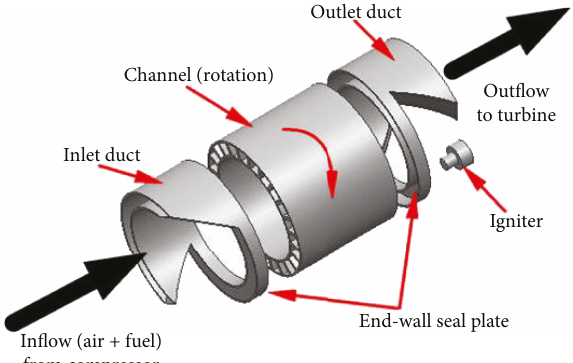
Figure 1: The typical WRC